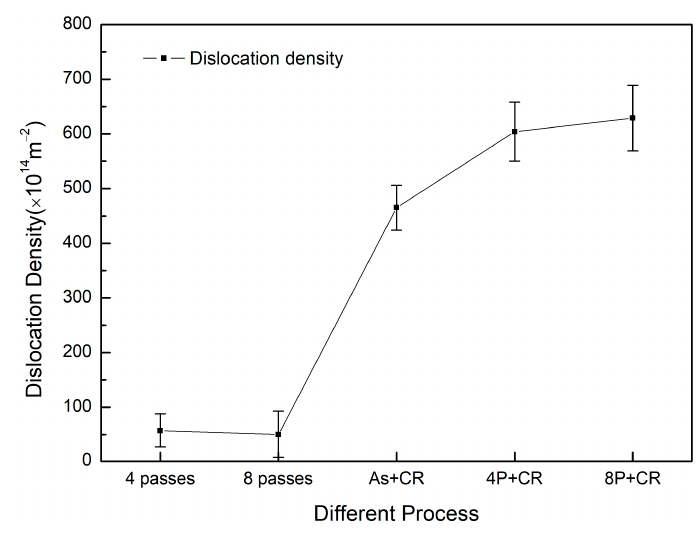
Figure 12. Evolutions of dislocation density in CP-Ti with different processing stages.